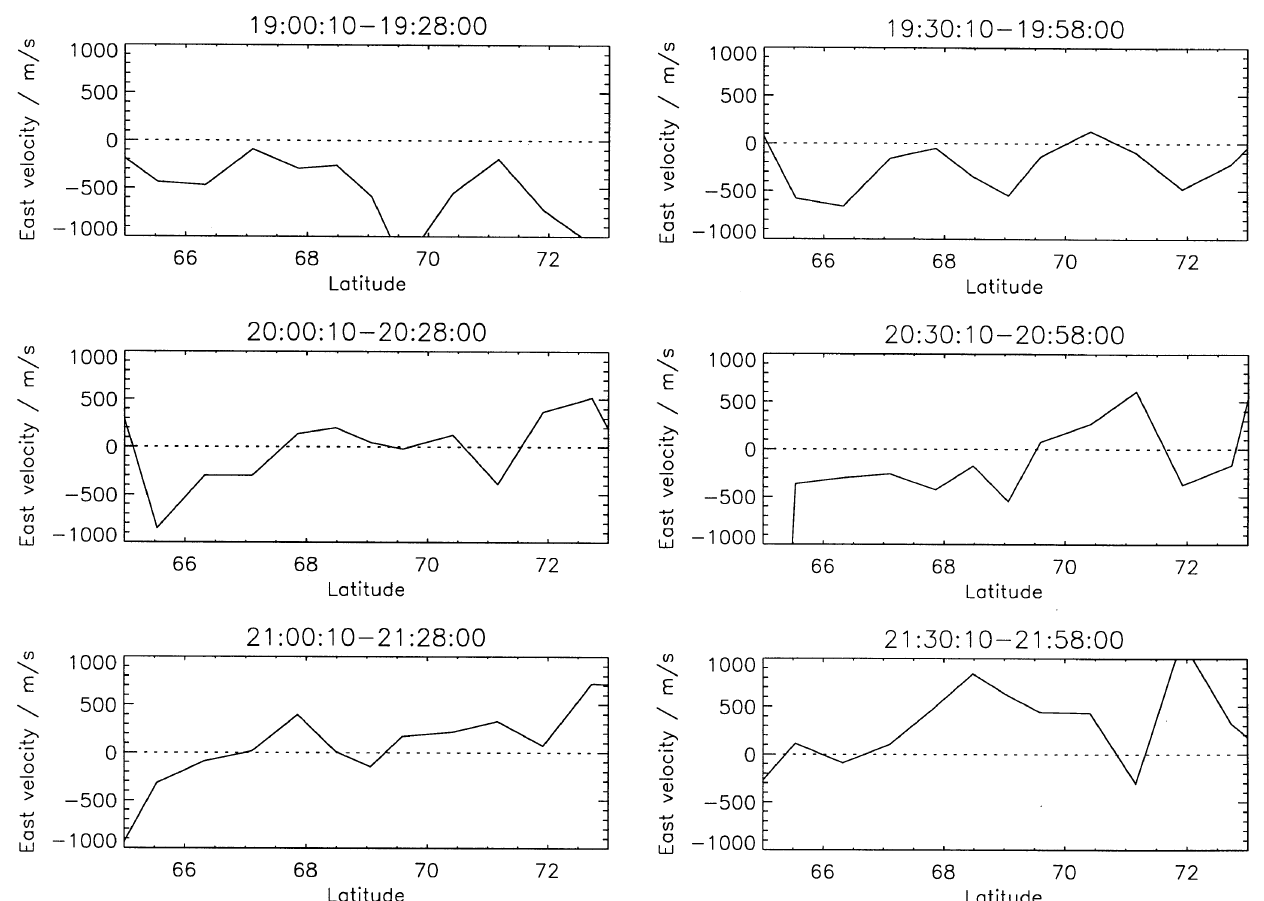
eastward convection channel arriving from the midnight sector in the manner of an avalanche, and which may be caused by a westward-expanding substorm electrojet into only slightly disturbed regions. Such events can cre- ate parallel arcs and may not be uncommon